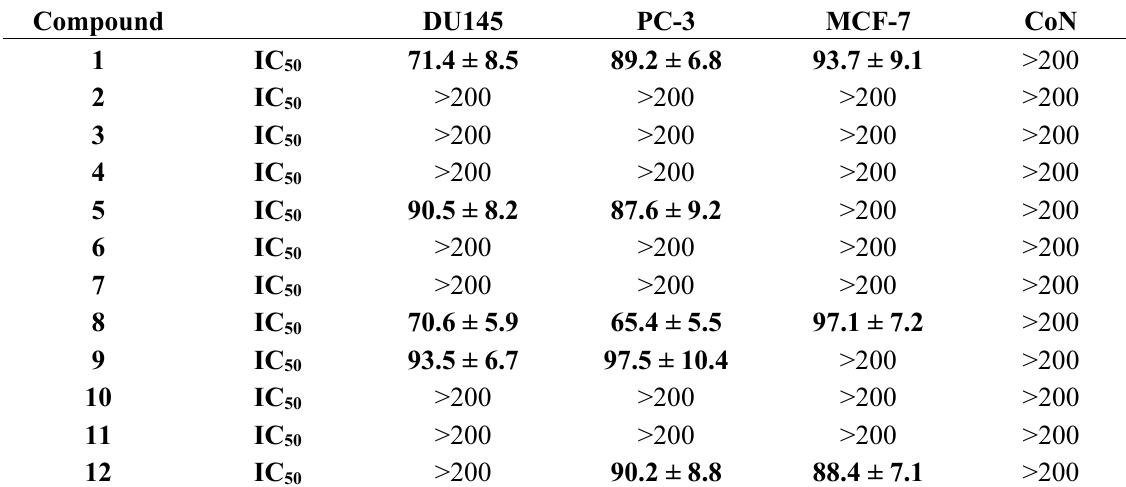
Table 1. Cytotoxicity (IC 50 μ M) of compounds 1 – 12